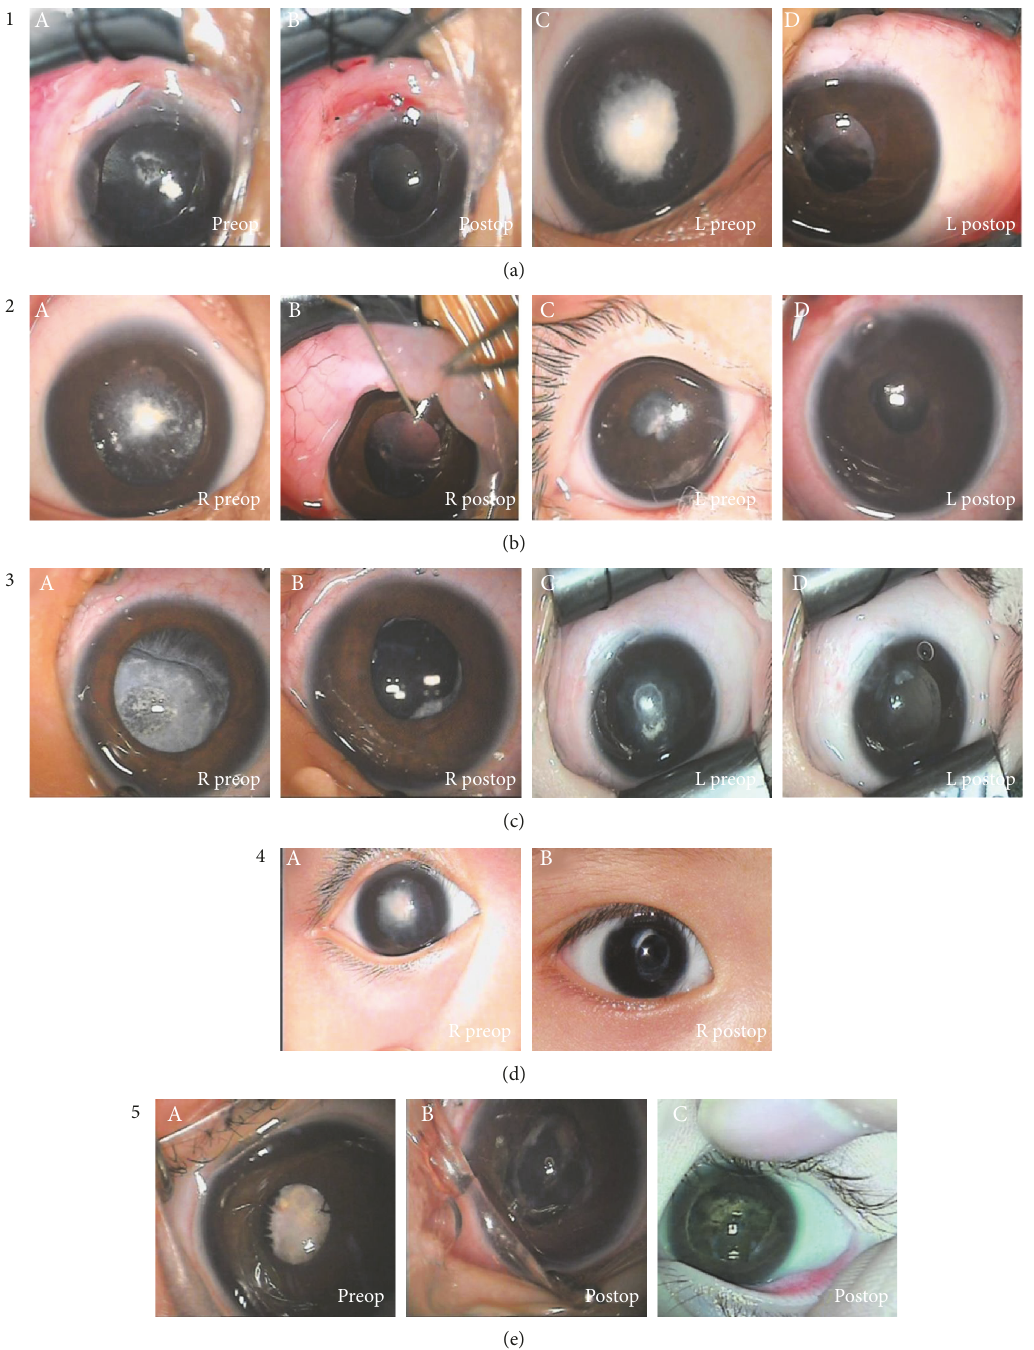
Figure 2: Operating microscope photographic images for di ff erent classi fi cations of cataract. OM-type 1 (a): the cortex was partially absorbed. (A, C) The pupil was covered by a daisy-like white opacity in the central region with a semiclear area in the peripheral region before cataract surgery. (B, D) A clear visual axis appeared in the central pupil after cataract surgery. OM - type 2 (b): the cortex was mostly absorbed (missing). (A, C) The pupil was covered by a white central opacity before cataract surgery with a semiclear periphery. (B, D) A clear visual axis appeared in the central pupil region.OM - type 3 (c): the cortex completely absorbed (missing). (A, C) The dilated pupil was covered by a white opacity before cataract surgery. A semiclear area in the periphery was seen. (B, D) A clear visual axis in the central pupil was achieved. OM-type 4 (d): a few blood vessels were observed. (A) The pupil was covered by a white opacity contained in a central Hemal net before cataract surgery. (B) A clear visual axis in the central pupil was achieved after cataract surgery. OM - type 5 (e): many blood vessels were observed. (A) The pupil was covered by a white opacity. A white opacity containing a central red mass was visible. There were many vessels in the lens. (B) A clear visual axis in the central pupil during cataract removal surgery was observed. (C) A posterior capsule opaci fi cation could be seen in the pupil, and a delayed hemorrhage after surgery was